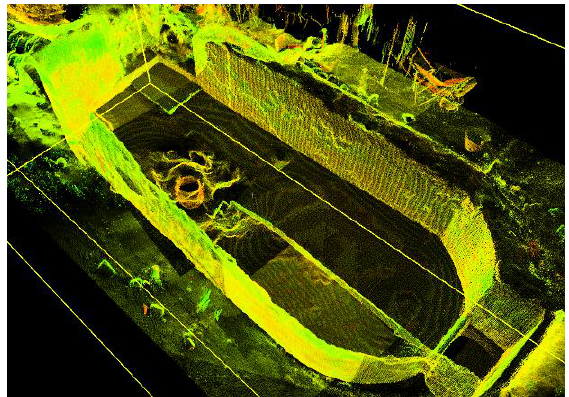
Fig. 4. Mithraeum of Multicoloured Marbles, Final Point Cloud